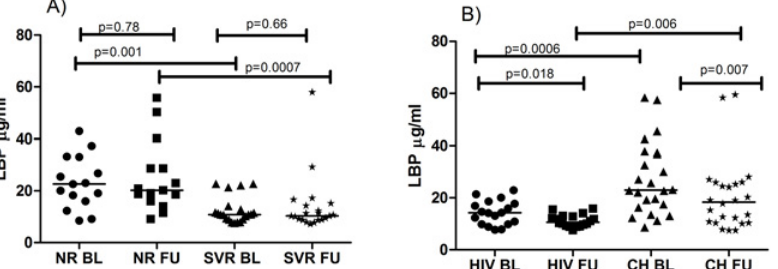
Fig 4. Kinetics of LBP. Baseline (BL) and follow-up (FU) levels of LBP levels during the study time was compared between Sustained viral responders (SVR) and non-responder (NR) group (A) and between HIV and HCV chronic (CH) group (B). Baseline and follow-up changes in LBP levels were assessed by Wilcoxon matched-pairs signed rank test. Mann Whitney U test was used to assess the differences between the groups at the same time point; p (cid:3) 0.05 was considered